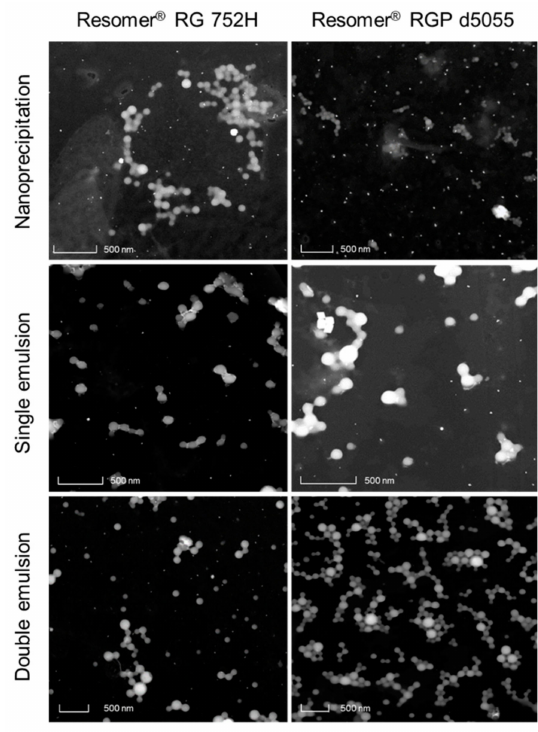
Figure 2. Scanning / transmission electron micrographs of nanoparticles comprising sorafenib in a Resomer ® RG 752H ( upper left ) or Resomer ® RGP d5055 ( upper right ) matrix prepared by nanoprecipitation, in a Resomer ® RG 752H ( middle left ) and Resomer ® , RGP d5055 ( middle right